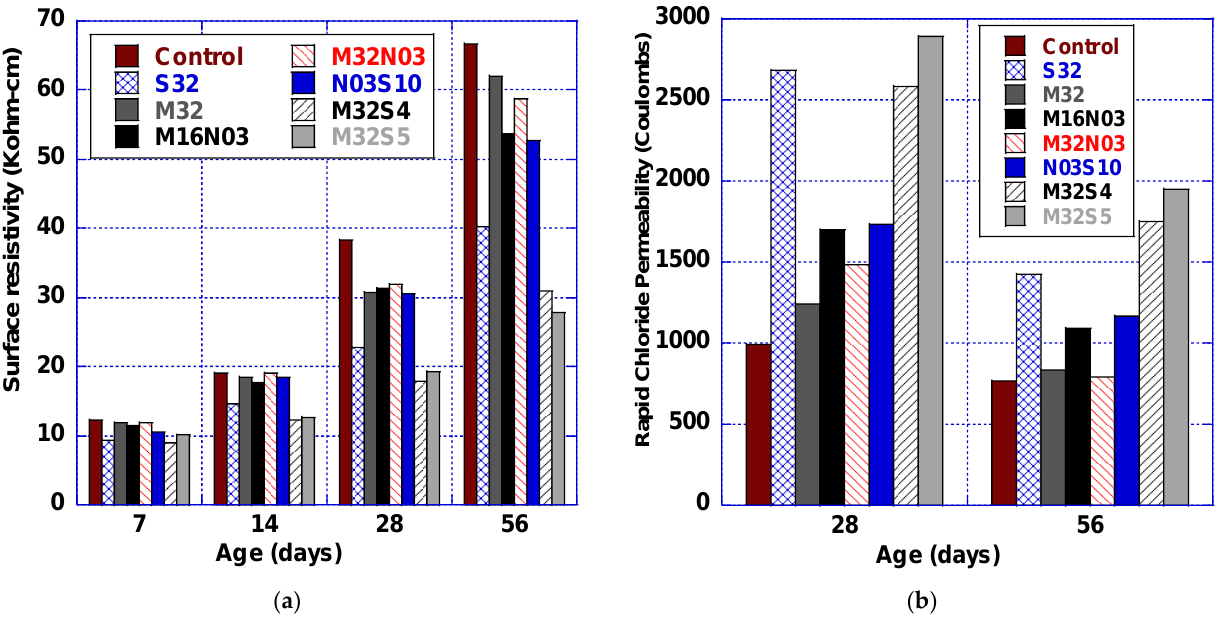
Figure 4. Durability performance of HFHPC: ( a ) surface resistivity ( k Ω -cm ) and ( b ) rapid chloride permeability (Coulombs).